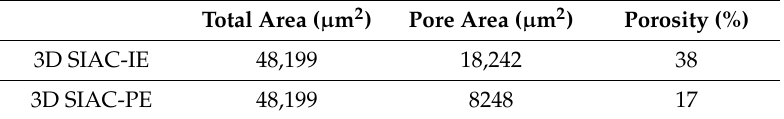
Table 1. Comparison of porosity measurement results of 3D SIAC-IE and 3D SIAC-PE.